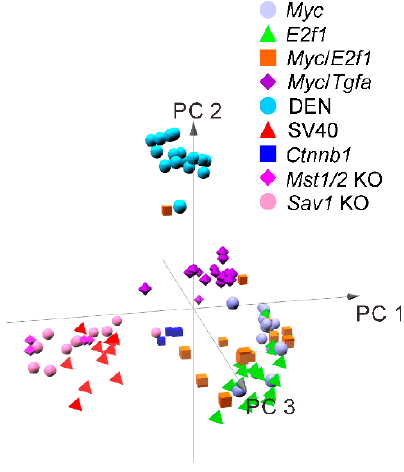
Figure 2. Cluster analysis of genetically engineered mouse model gene expression shows interrelationship among tumors with similar gene expression.